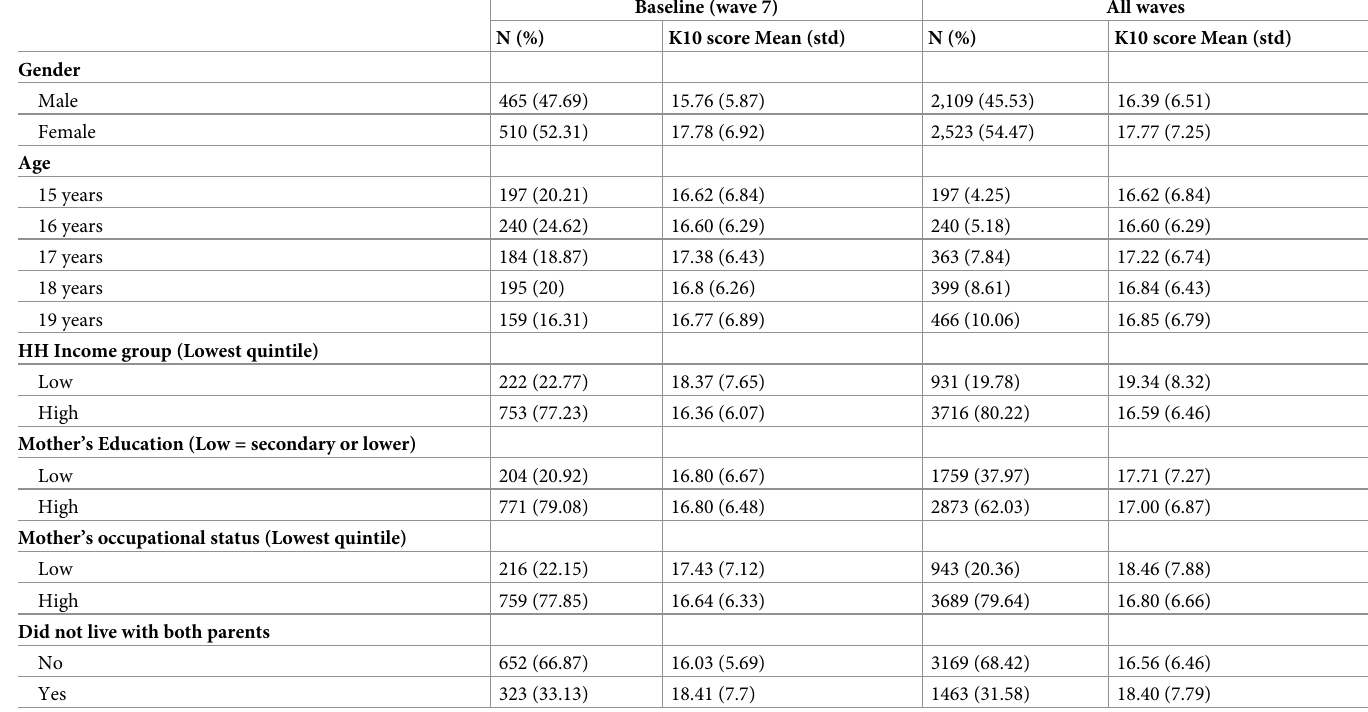
Table 1. Socio-demographic characteristics of the study population by mental health status. Baseline (wave 7) All